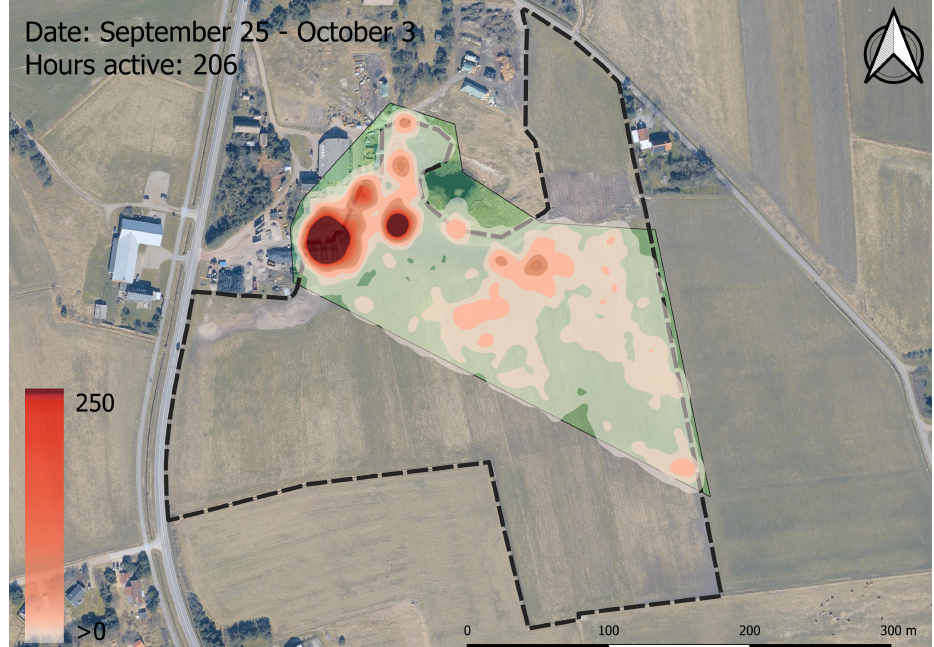
Figure 2. Heatmap visualising all Poll messages sent during the period from 25 September to 3 October. The green area shows the virtual enclosure area to which the bull calves were limited. The white to red colour scale indicates the number of Poll messages within a 10 m radius on a discrete scale, ranging from 1 point to above 250 points. The coordinates of the upper left corner of the map frame are 55°25 (cid:48) 23.131 (cid:48)(cid:48) E 8°23 (cid:48) 53.531 (cid:48)(cid:48) N. Contains data from the Agency for Data Supply and Infrastructure, Forårsbilleder Ortofoto-GeoDanmark, December